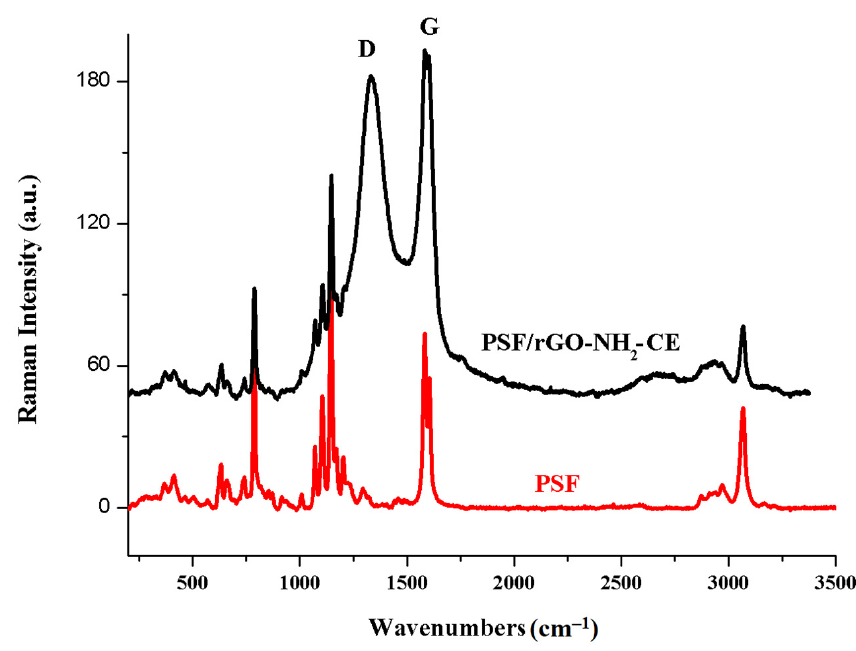
Figure 7. Raman spectra of PSF and PSF/rGO-NH 2 -CE.